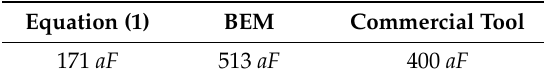
Table 3. Comparison of the self-capacitance based on 3 methods: Equation (1), BEM, and the commercial